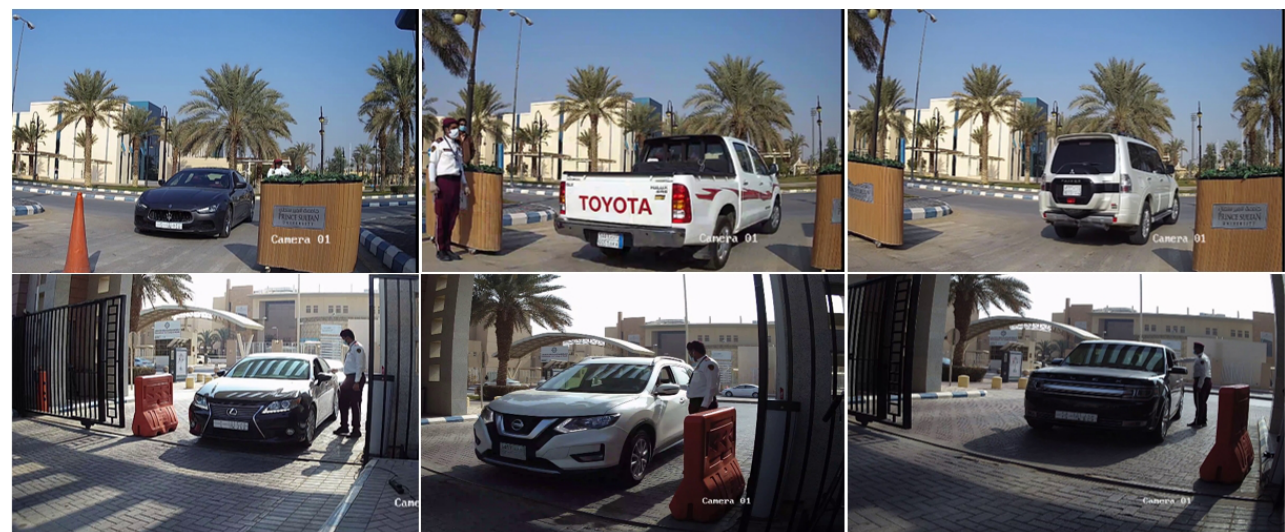
Figure 13. Sample images extracted from two videos for evaluating car model and license plate recognition. The images at the top are from video 1, which was recorded at the employees’ parking lot entrance, while the images at the bottom are from video 2, which was recorded at the main gate of PSU campus. As can be observed in this sample, the license plate characters are hardly readable on some frames.